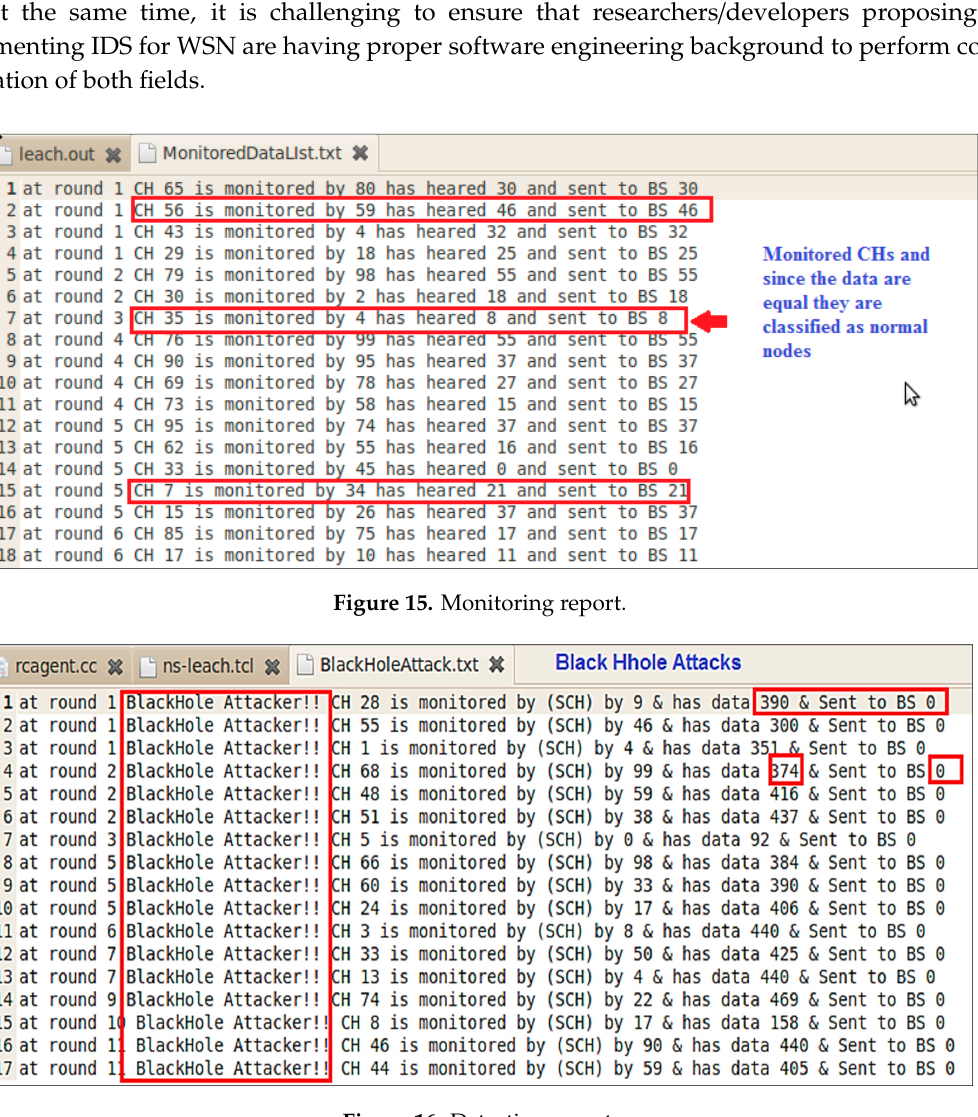
Figure 16. Detection report.